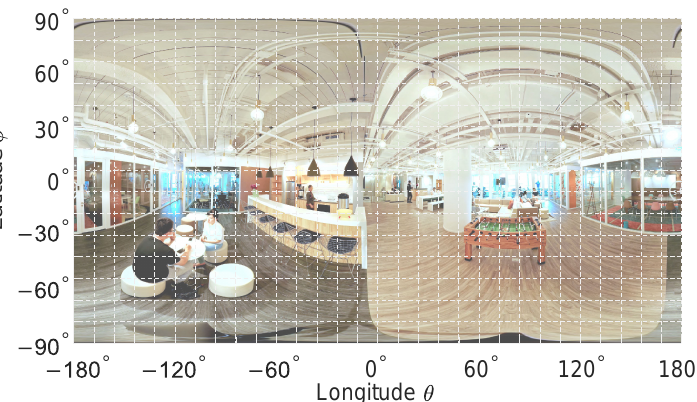
Figure 1. Example of an equirectangular projected 360 ◦ video frame with uniformly distributed samples of latitude and longitude.